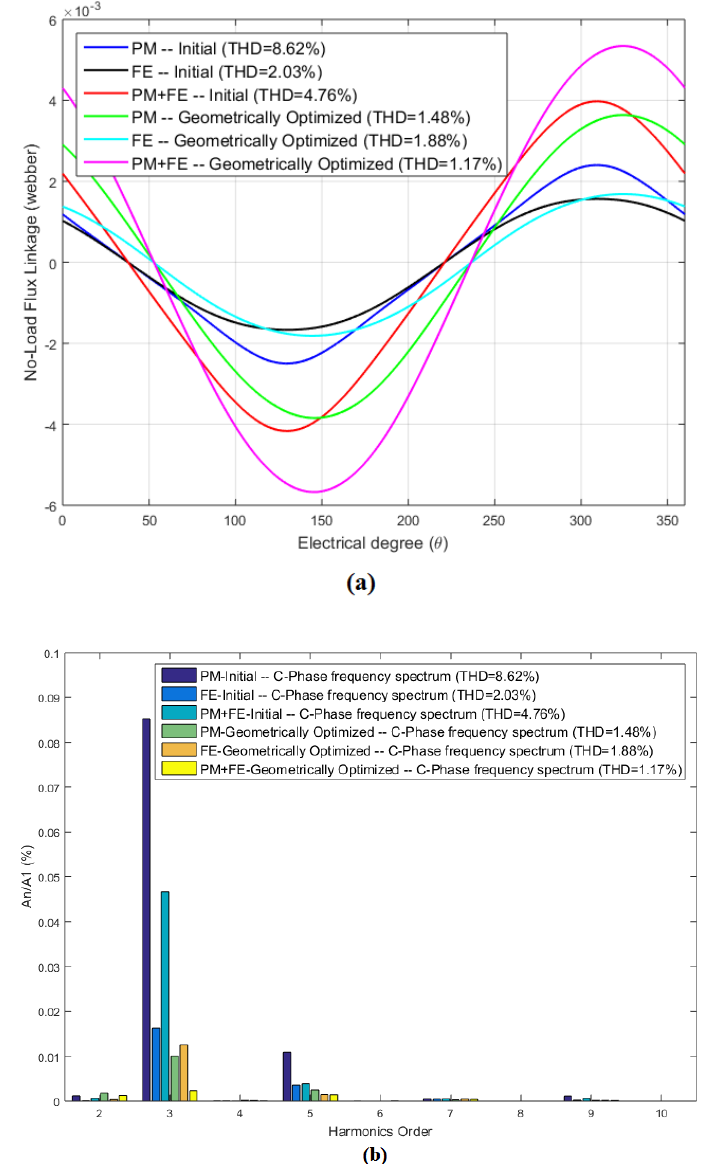
Figure 8. No-load flux linkage comparison: (a) waveforms and (b) frequency spectrum.